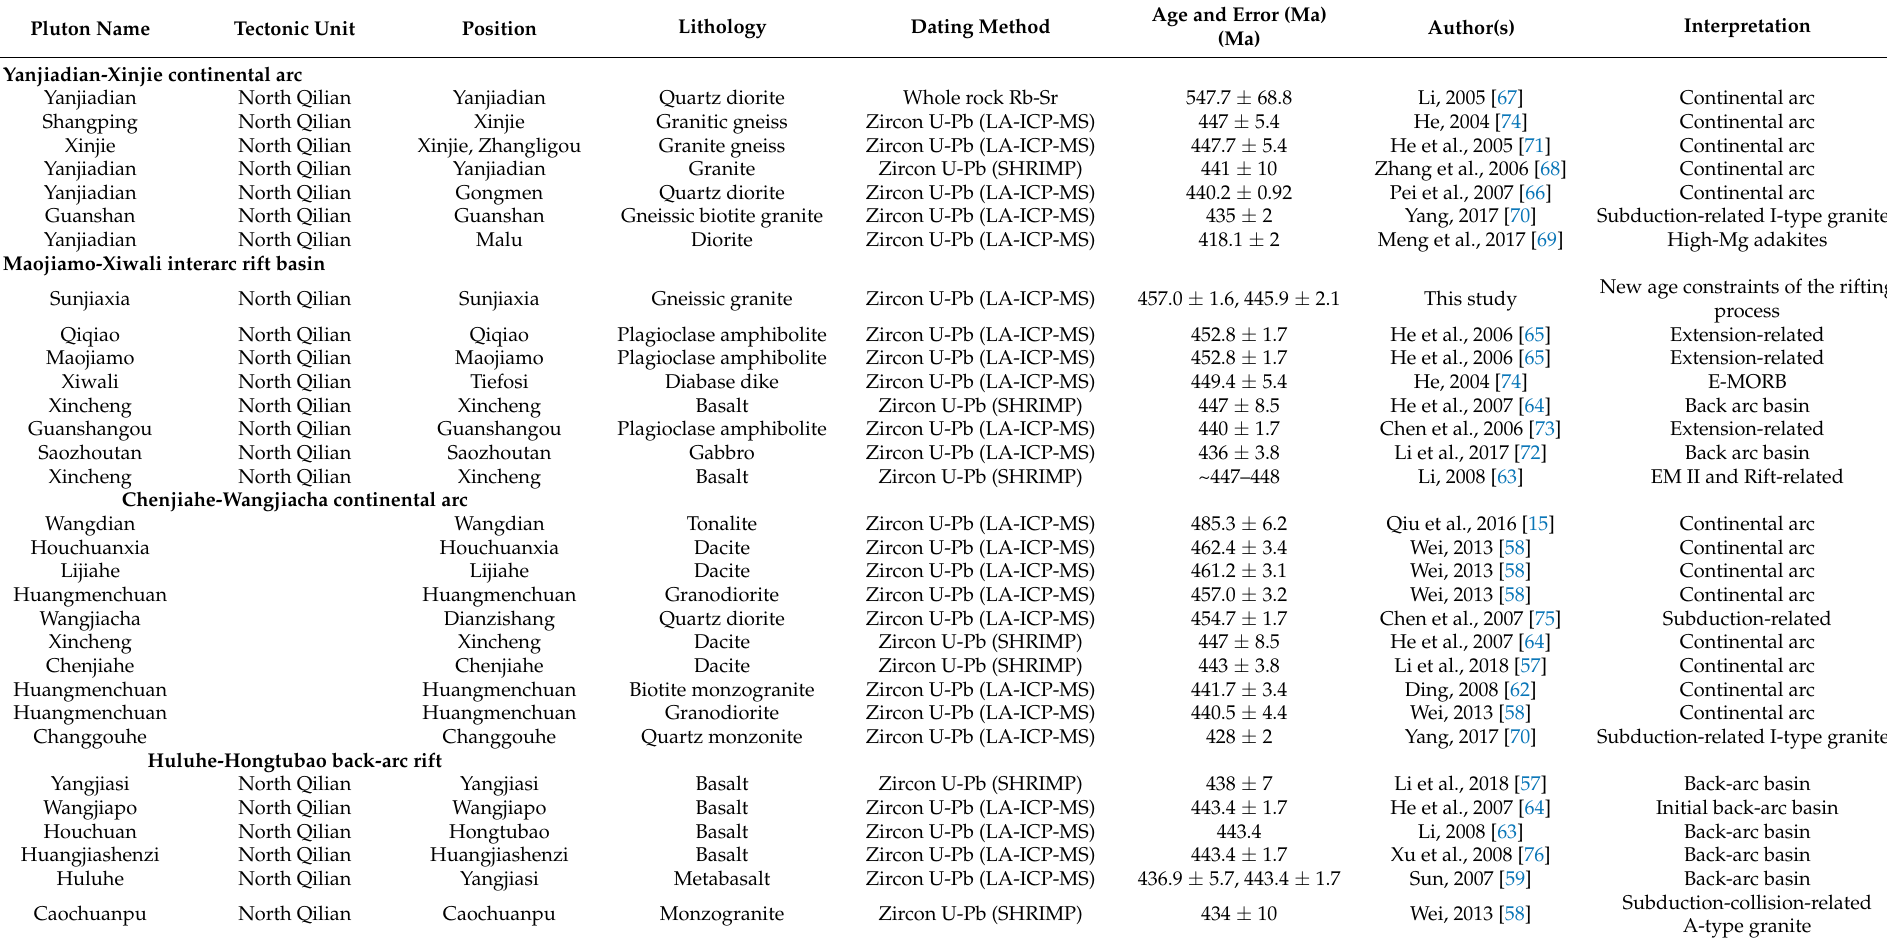
Table 1. Summary of zircon U-Pb ages and tectonic implications of igneous rocks in the connection zone of NQO and